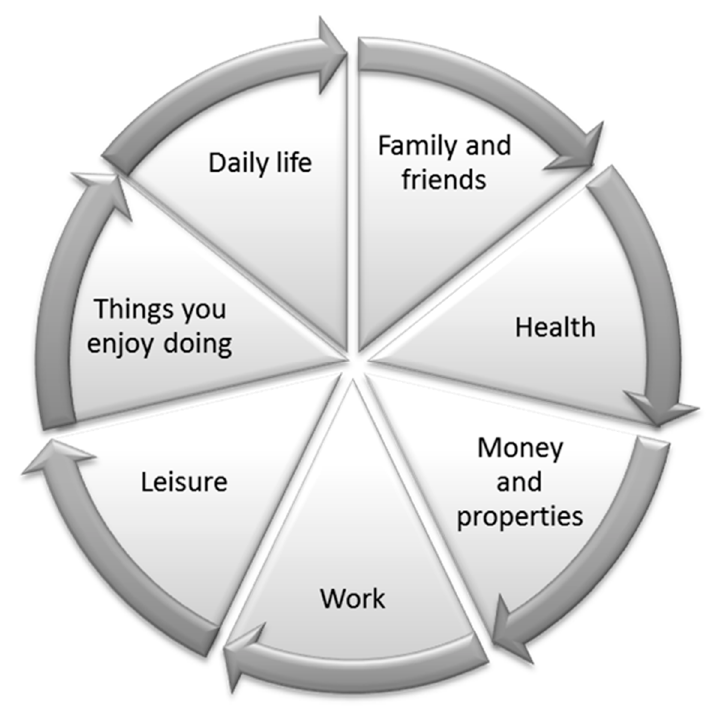
Figure 1. Pie Chart of ‘Life Overall’.